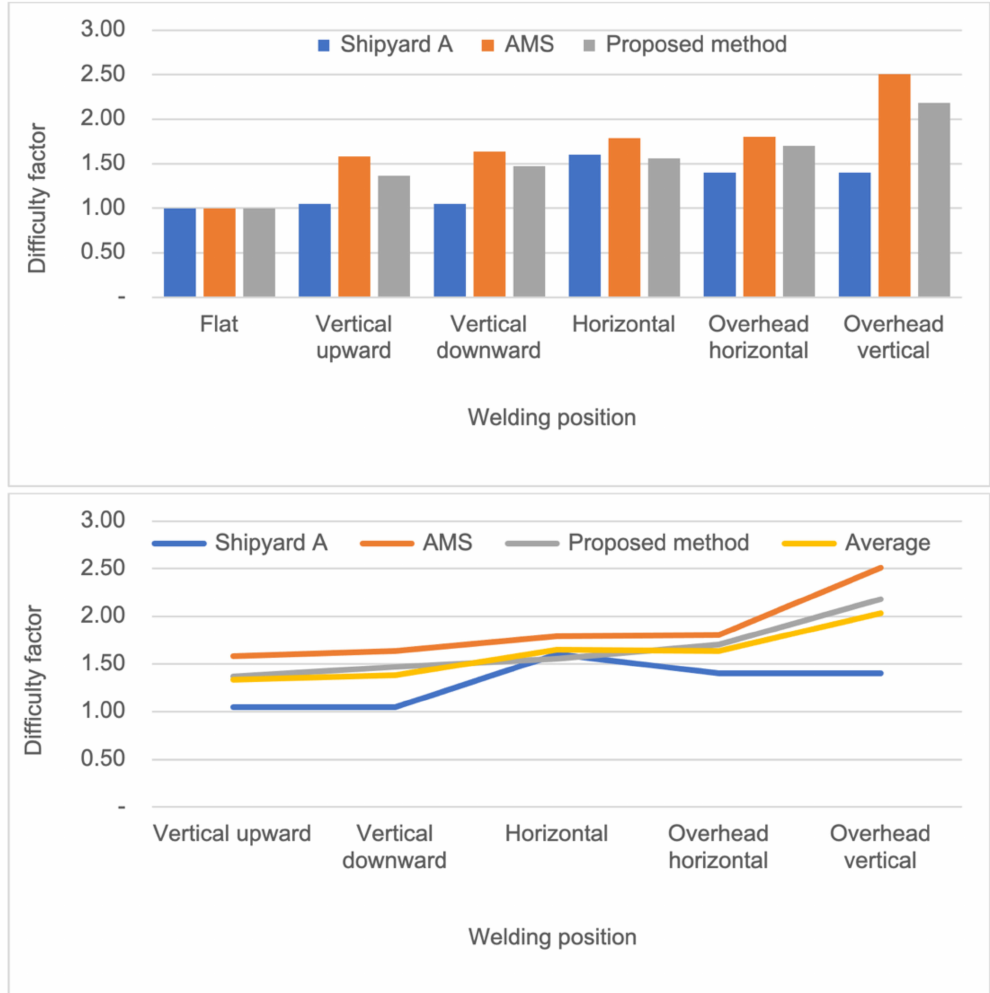
Figure 13. Comparison of welding difficulty factors of three different methods, based on the flat position of each